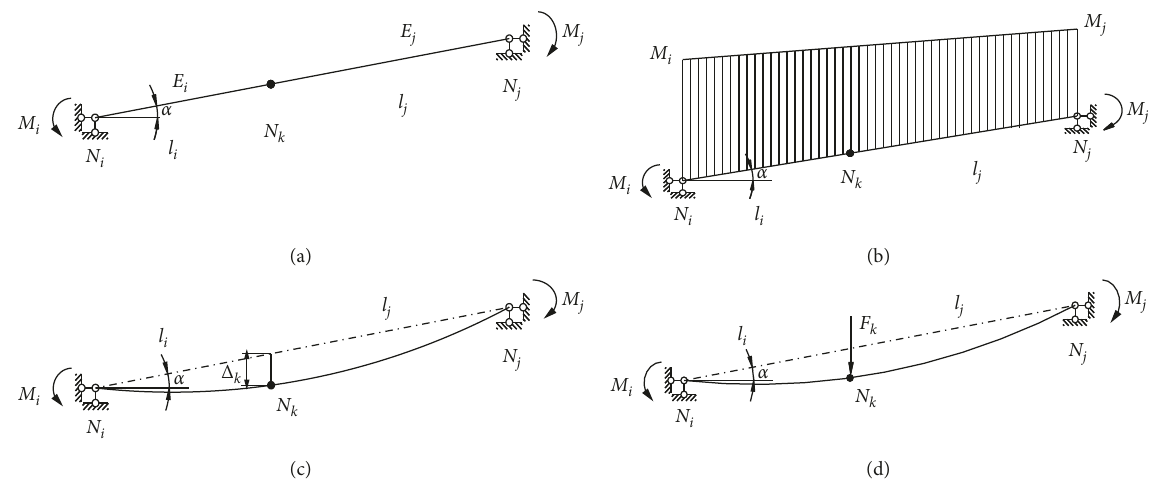
Figure 3: Simplified calculation model of the main tube. (a) Simplified structural diagram of the main tube. (b) Simplified bending moment diagram of the main tube. (c) Adjustment value Δ k of node N k . (d) Equivalent concentrating force F k of node N k